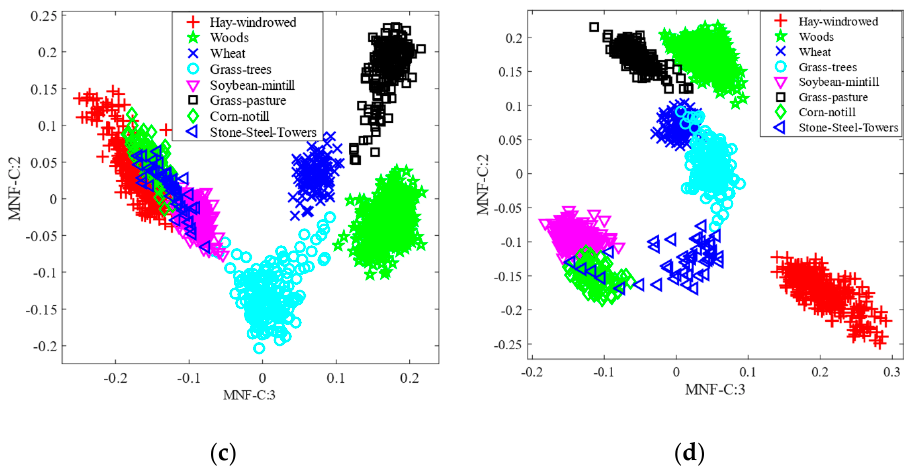
Figure 9. Feature space on the AVIRIS IP dataset: ( a ) MNF; ( b ) MNF-MI; ( c ) MNF-CCRE; and ( d ) MNF-nCCREmRMR.